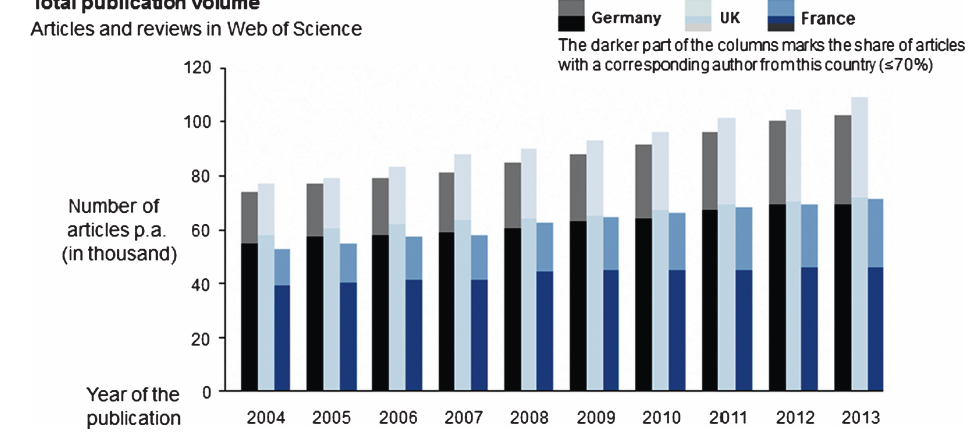
Figure 1. Publication volume with APC-relevant share of selected European